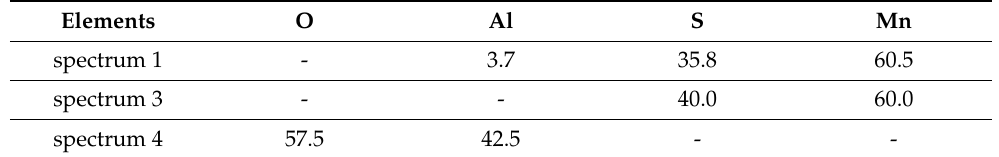
Figure 9. EDX spectra of individual particles in Bi-free CMnCr steel. Table 3. Chemical composition of particles in Bi-free CMnCr steel [wt. %].